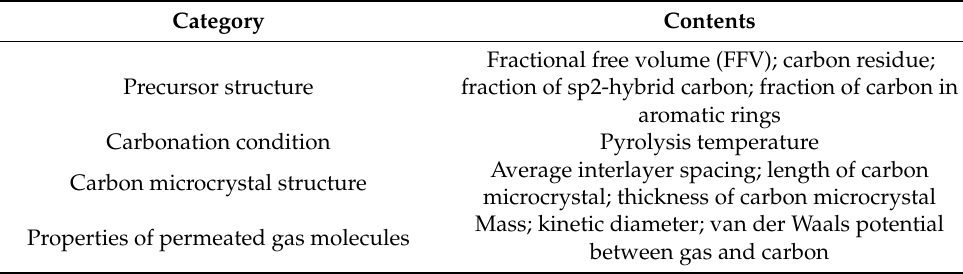
Table 1. The selected factors for analyzing the structural–performance relationship of CMS membrane.